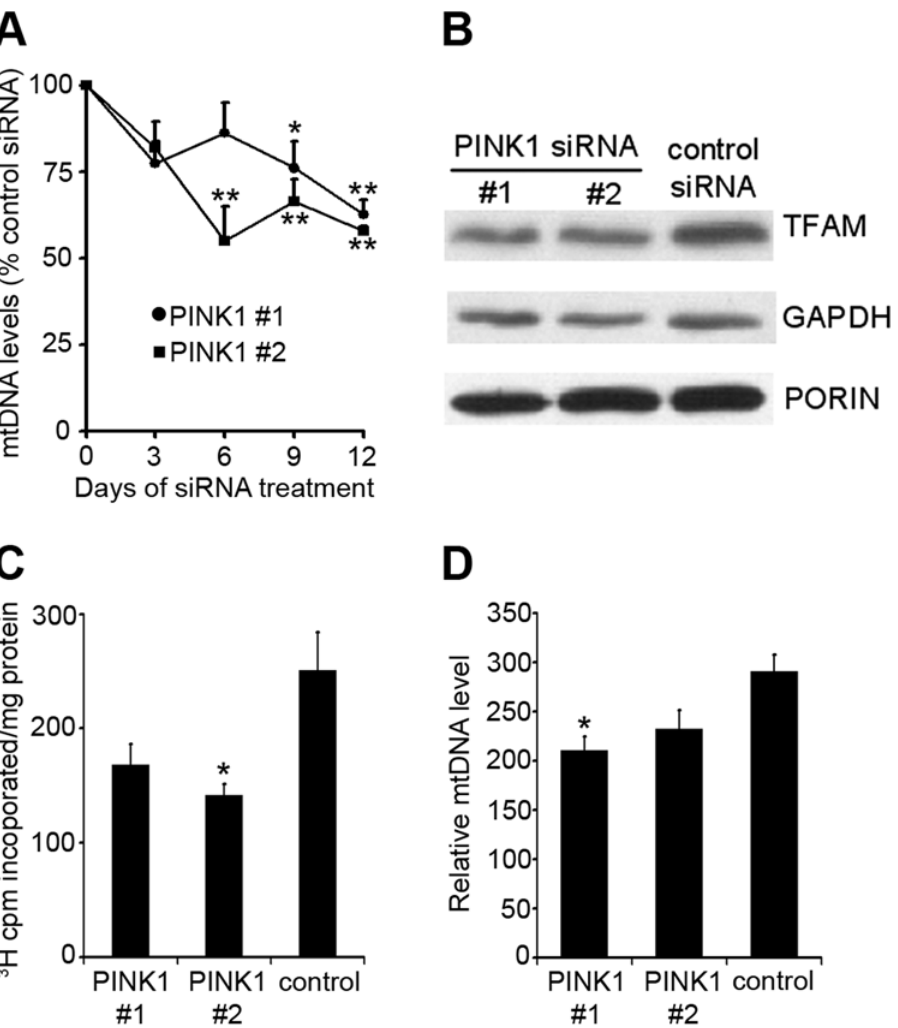
Figure 2. Measurement of mtDNA levels and synthesis in PINK1-silenced SH-SY5Y cells. A, SH-SY5Y cells were treated with PINK1 or scrambled control siRNA for 3, 6, 9 or 12 days and mtDNA levels measured by quantitative real-time PCR. MtDNA levels were expressed relative to the single copy nuclear gene TK2 . Data are expressed as percentage of control siRNA mtDNA levels ( n =4). B, cells were treated with siRNA for 12 days and cell lysates probed for TFAM, GAPDH and porin by western blot. C, SH-SY5Y cells were treated with siRNA for 6 days and de novo mtDNA synthesis measured by quantifying the incorporation of [methyl- 3 H]thymidine into mtDNA over an 18-hour period in the presence of aphidicolin. Data are expressed as 10 3 counts per minute incorporated per mg of protein and are the mean 6 s.e.m ( n =4). D, SH-SY5Y were treated with PINK1 siRNA for 6 days in the presence of 10 m M ddC, and then the ddC washed away, and the cells incubated for a further 3 days in the presence of siRNA before mtDNA levels were measured ( n =4). * P , 0.05 vs. scrambled control siRNA; ** P , 0.01 vs. scrambled control siRNA.